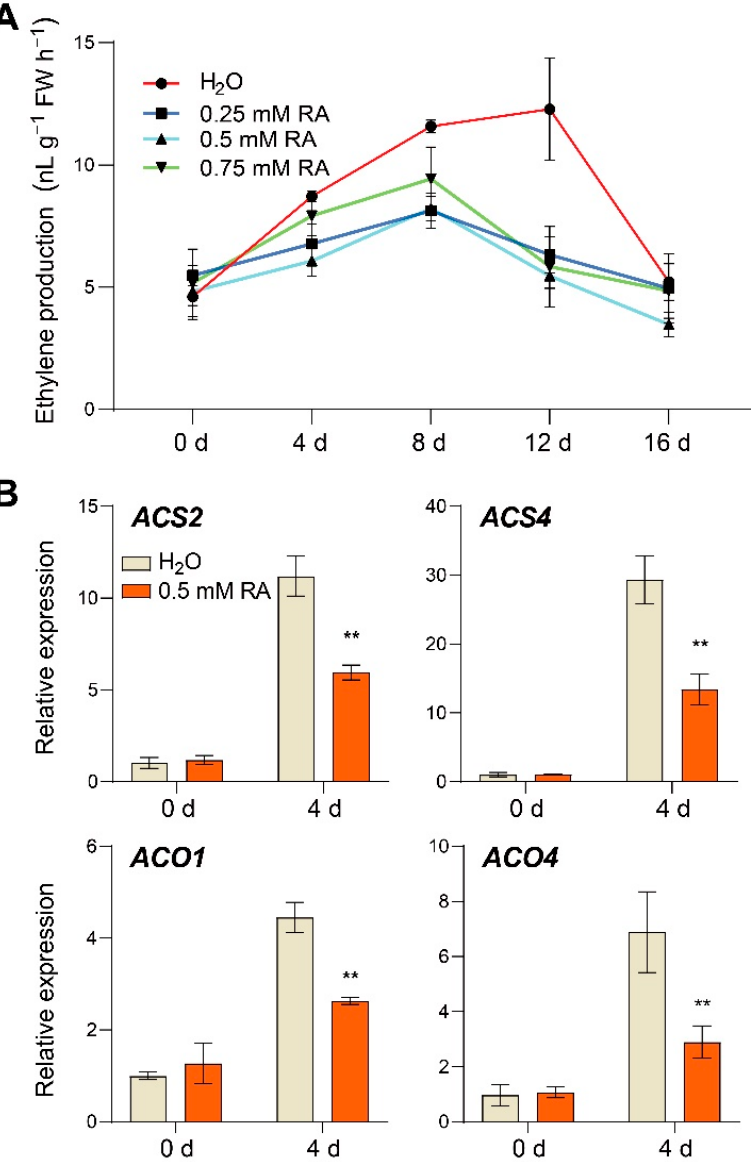
Figure 2. RA inhibited ripening-induced ethylene biosynthesis signaling. Effects of RA treatment on ( A ) ethylene production, and ( B ) transcript abundance of ethylene biosynthesis genes ACS2 , ACS4 , ACO1 , and ACO4 . The transcript abundance of each gene under control at 0 d was defined as 1. Tomato fruits at the mature green stage were treated with 0.25 mM, 0.5 mM, 0.75 mM RA, or H 2 O control. The fruit samples were collected at the indicated time points for ethylene content quantification and qRT-PCR analysis. The data are presented as mean values ± SD; n = 4 in ( A ), 3 in ( B ). Asterisks in ( B ) indicate statistically significant differences (** p ≤ 0.01) compared with control under the same time point, as determined by Student’s t -test.